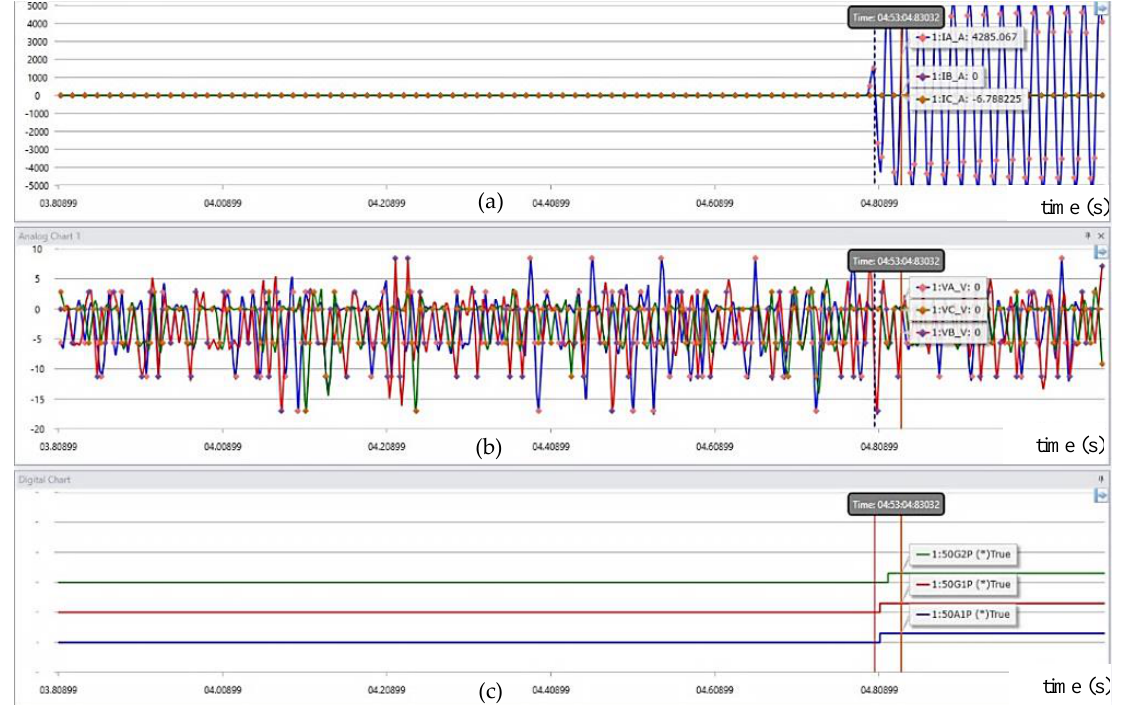
Figure 8. Fault waveforms and tripping signals corresponding to the SPGF at F1: ( a ) three phase currents (Ia (A), Ib (A), and Ic (A)); ( b ) three phase voltages (Va (V), Vb (C), and Vc (V)); ( c ) tripping signals of the ground OC relay (50G1P and 50G2P are two tripping signals of the ground OC relay at levels 1 and 2, respectively, while the 50A1P shows a faulted phase-A).